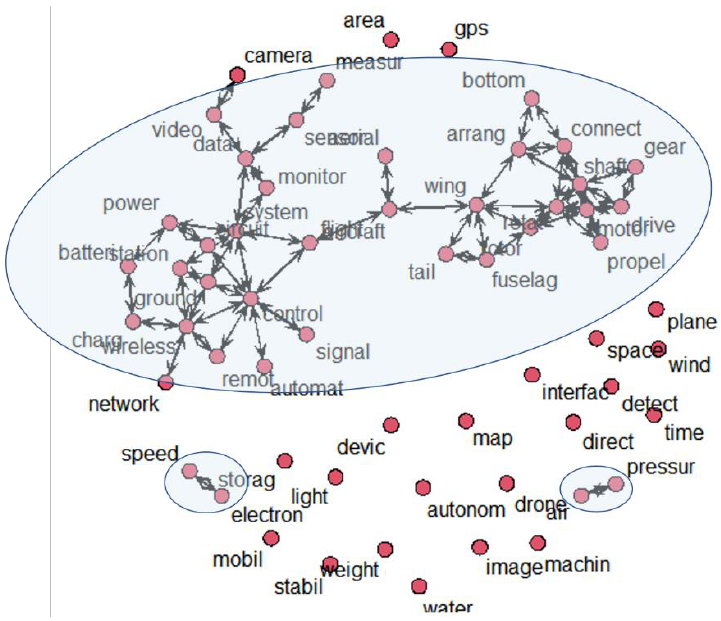
Figure 9. Keyword correlation network (correlation coefficient = 0.1).